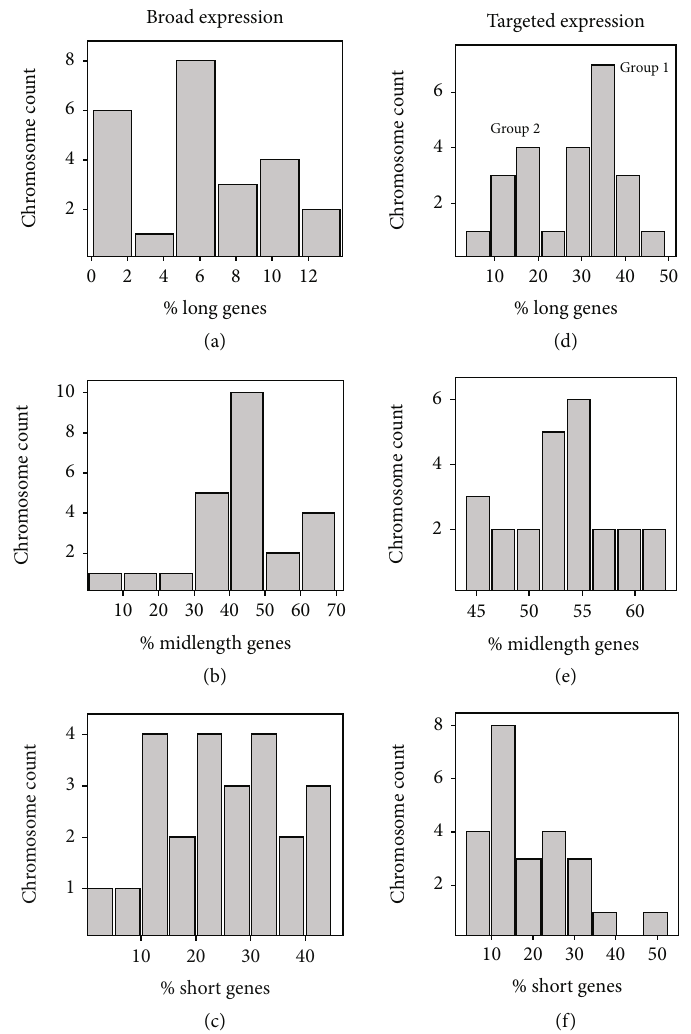
Figure 4: Chromosome count of short, midlength, and long genes as a function of their content in the 24 human chromosomes. Broadly expressed and tissue-targeted database genes are plotted separately. Note that distinct chromosome constellations are observed in all six chromosome populations. Group 1 and group 2 populations as shown in (d) were employed for studies of the e ff ect of chromosome on gene expression (see